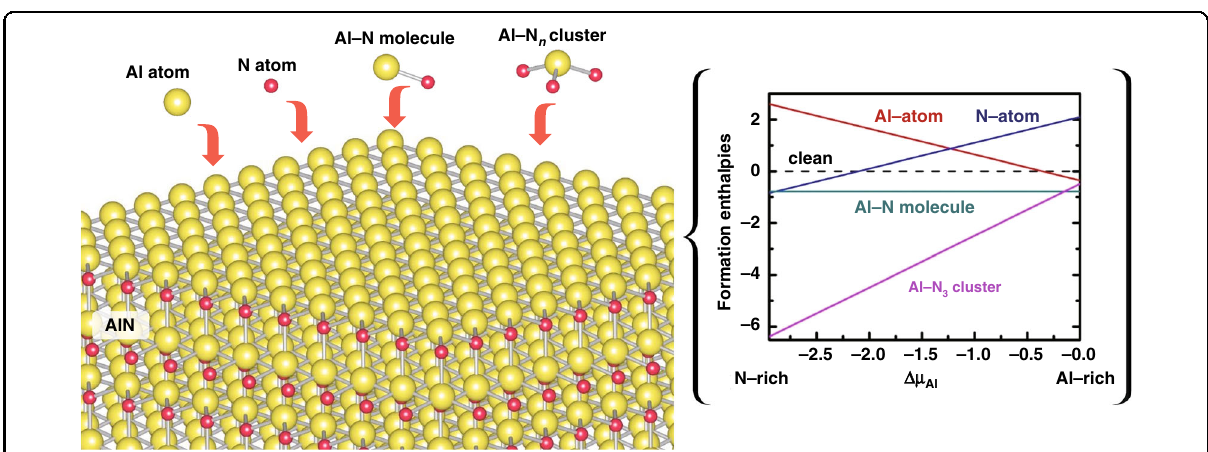
Fig. 3 Formation enthalpies of the AlN surfaces with an Al atom, N atom, Al – N molecule, and Al – N 3 cluster adsorption as the function of the Al chemical potential. Figures reproduced from ref. 57 , © 2013 American Chemical